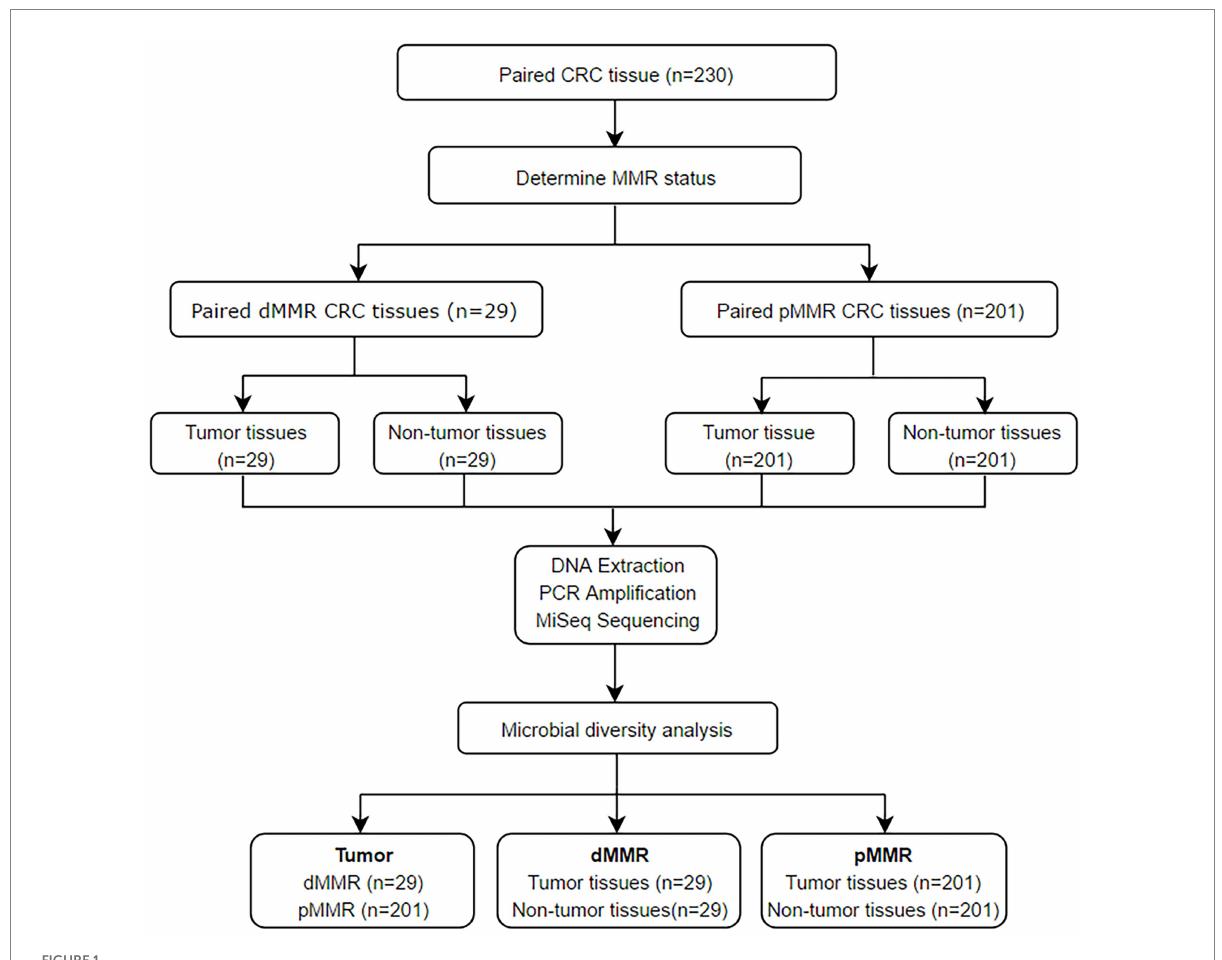
FIGURE 1 Flowchart of the proposed